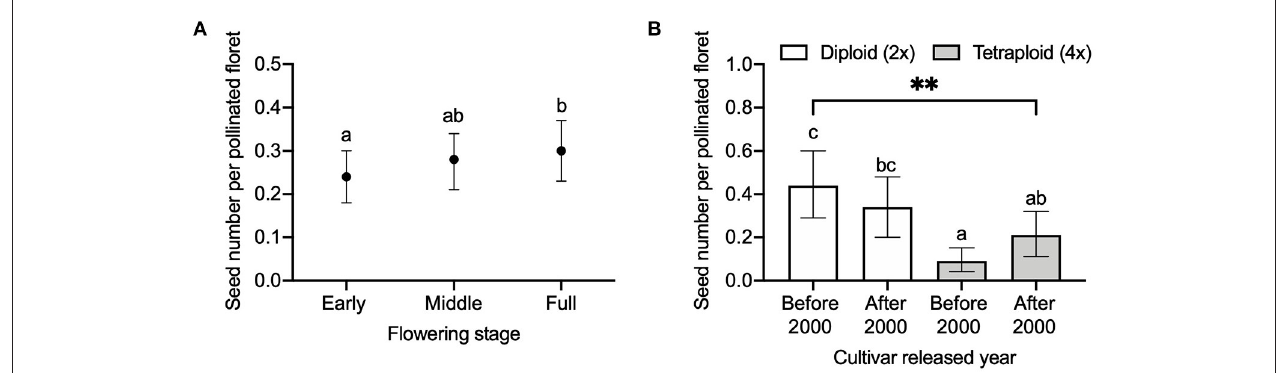
FIGURE 4 | Comparison of seed number per pollinated floret (A) among different flowering stages of early, middle, and full and (B) between diploid (2 × ) and tetraploid (4 × ) red clover cultivars released before 2000 and after 2000. Error bars indicate the 95% confidence interval of the estimated marginal means (EMMs). EMMs sharing a lowercase letter within the same figure are not significantly different at 0.05 significance level. ** P- value = 0.0075.